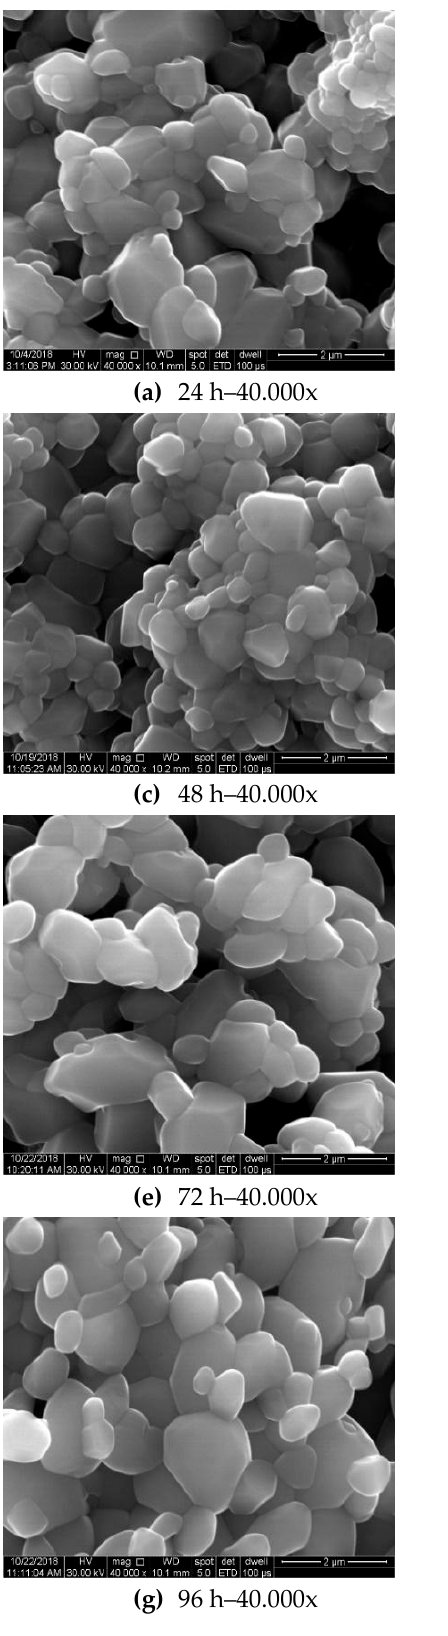
Figure 8. Microstructural evolution of the oxide scale over 96 h of isothermal oxidation at 1050 ◦ C ( a , c , e , g ) and 900 ◦ C ( b , d , f , h